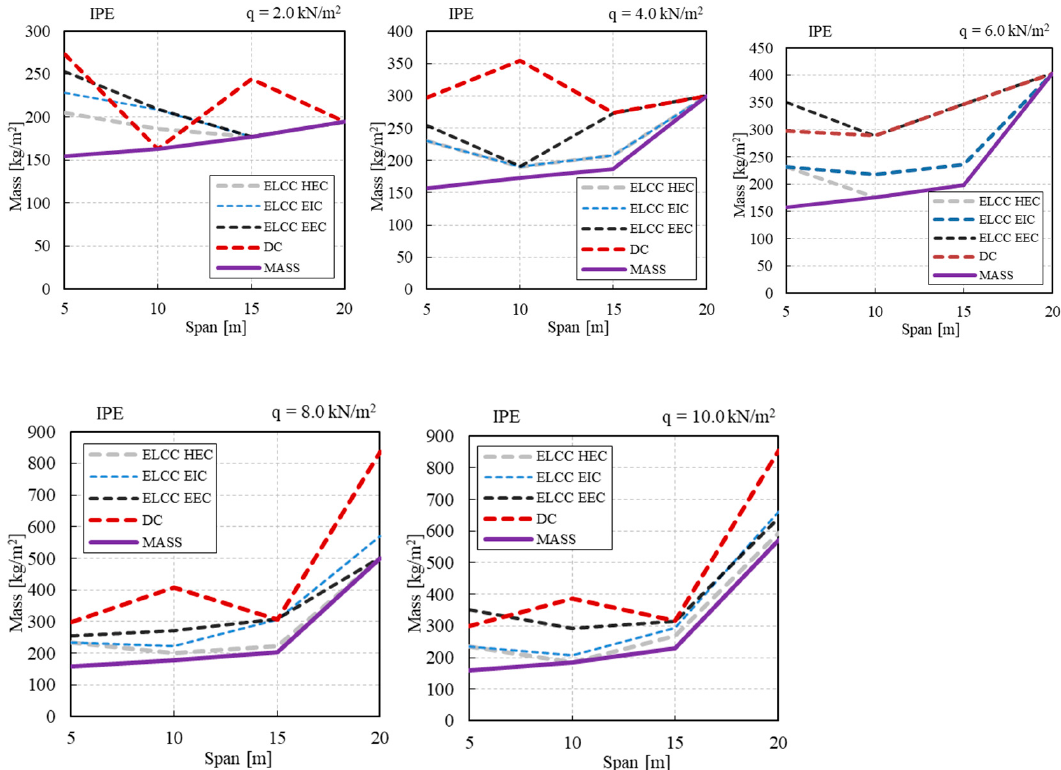
Figure 14. Diagrams of the calculated masses of the CFSIPE structures for different objective functions.